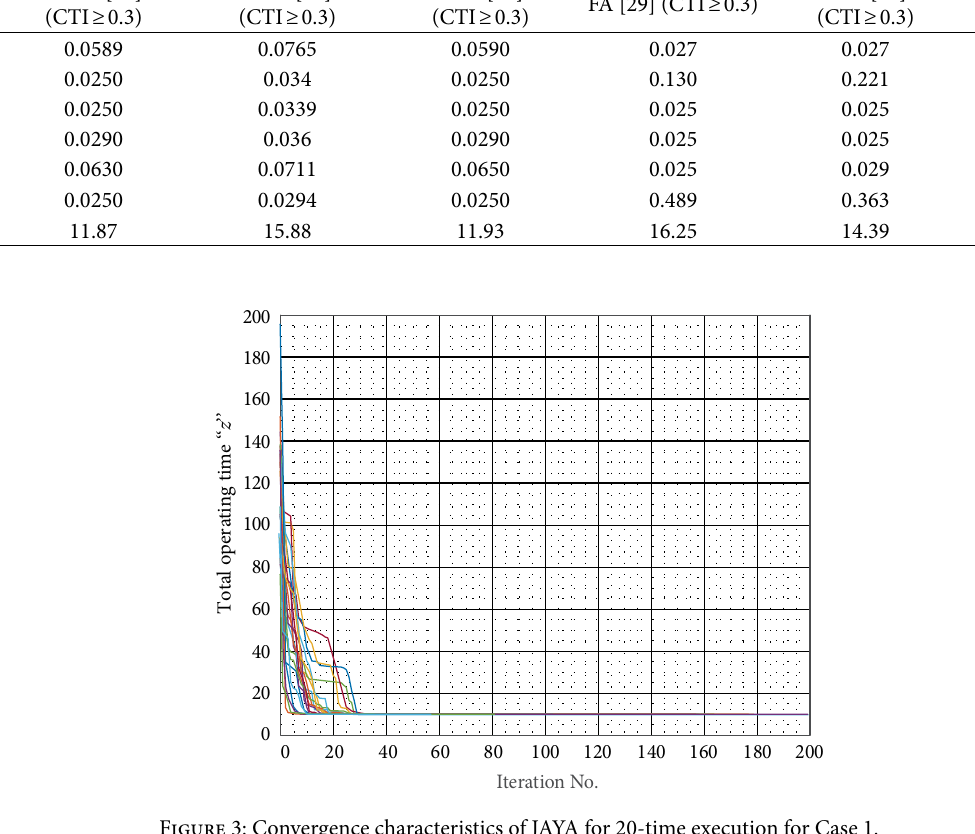
Figure 5. A different combination and configuration of the